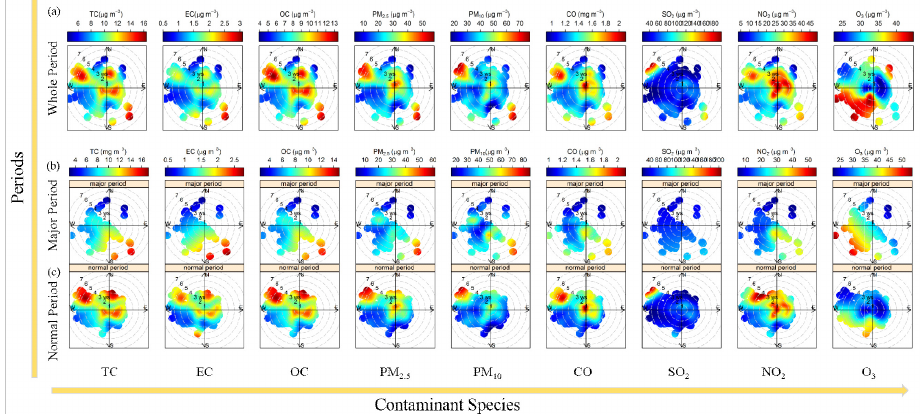
Figure 5. The relationship of pollutant concentration (from left to right: TC, EC, OC, PM 2.5 , PM 10 , CO, SO 2 , NO 2 , and O 3 ) to wind direction and wind speed during the 2018 Spring Festival (i.e., from Lunar 20 December to Lunar 20 January of the following year) in Changchun. ( a ) Relationship of various pollutant concentration to wind direction and wind speed throughout the entire Spring Festival. ( b , c ) Relationship of pollutant concentration to wind direction and wind speed in the major and normal period of the Spring Festival,